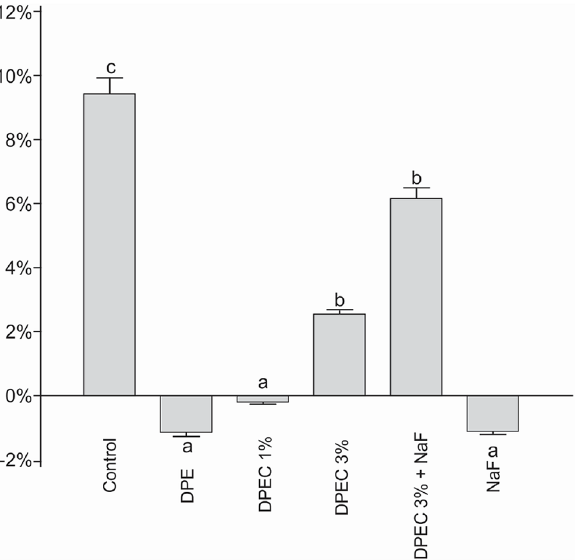
Figure 1. Mean rates (n = 10) and SD of the percentage surface hardness change (%SHC) for chitosan film containing pyroligneous extract treatments and control (saline solution). Enamel protection is indicated